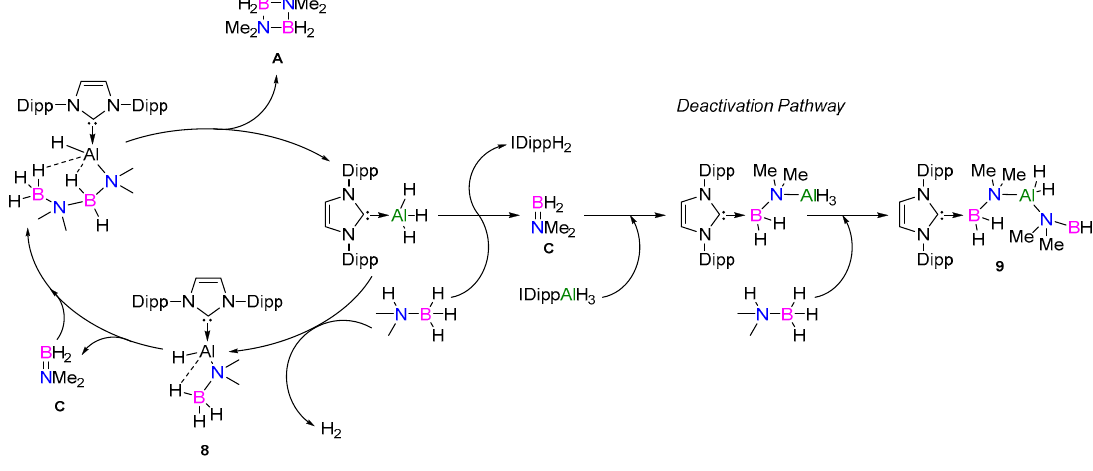
Figure 8. Proposed mechanism for the dehydrocoupling of Me 2 NHBH 3 with NHC-supported Al(III) hydrides ( 3 – 6 ).